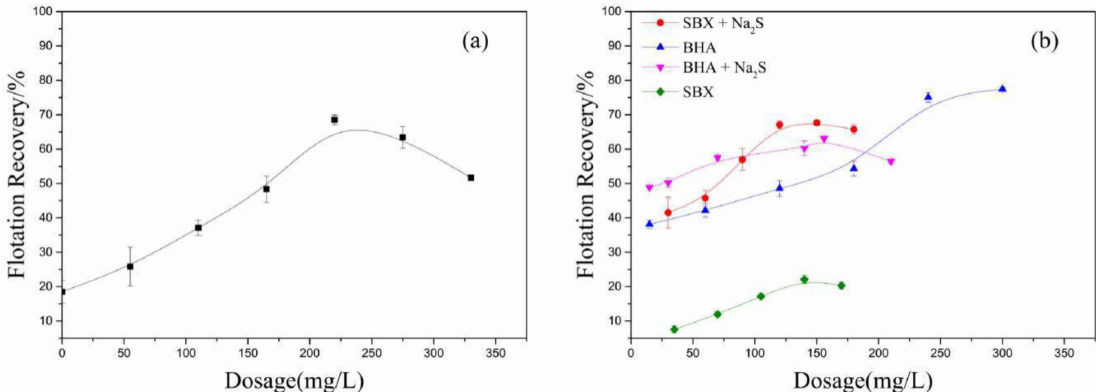
Figure 3. ( a ) Effect of Na 2 S dosage on the recovery of malachite. The dosage of sodium butyl-xanthate (SBX) is 220 mg/L, pH = 9.5, the dosage of foaming agent is 40 mg/L. ( b ) Effect of dosage of SBX/ benzohydroxamic acid (BHA) on the recovery of malachite in the presence/absence of Na 2 S. In the absence of Na 2 S, pH is 9.5, and the dosage of terpenic oil is 40 mg/L. In the presence of Na 2 S, pH is 9.5, the Na 2 S dosage is 220 mg/L, and the dosage of terpenic oil is 40 mg/L. Terpenic oil is used as a foaming